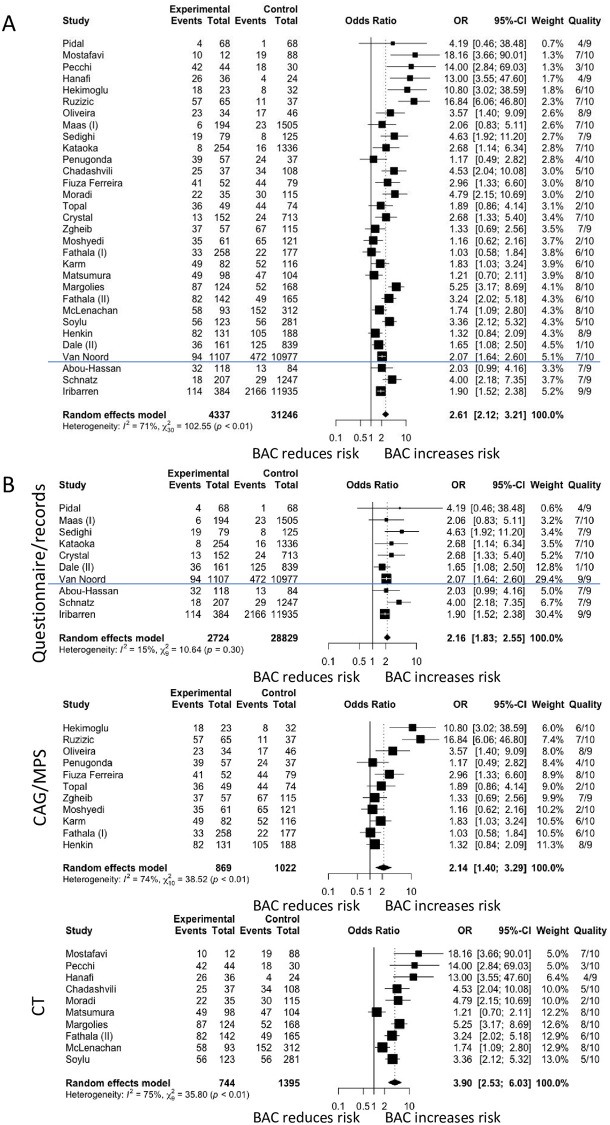
Forest plot analysis of breast arterial calcification (BAC) and coronary artery disease (CAD).Fig 2A shows the association of BAC and CAD when stratified based on study design. Fig 2B shows the association of BAC and CAD when stratified based on modality of determining CAD. The blue line separates cross sectional and cohort studies. (CT: computed tomography; CAG: coronary angiography.